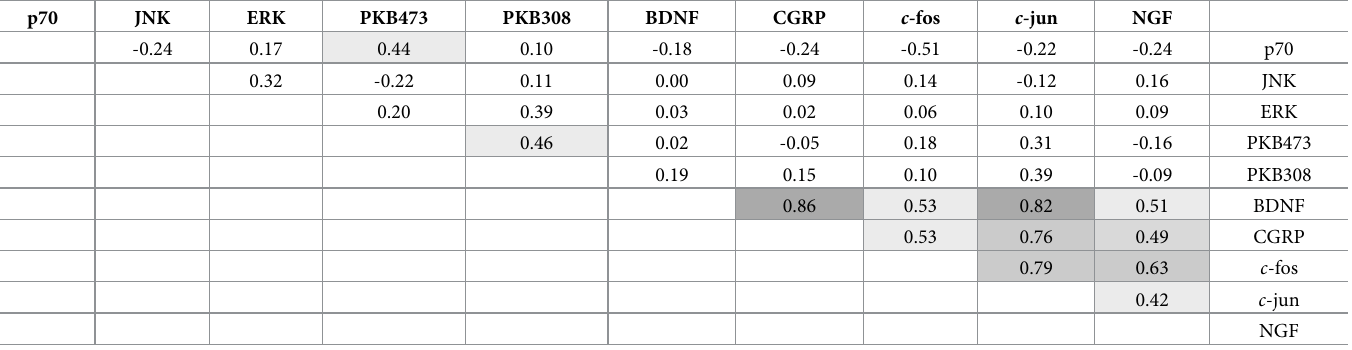
Table 2. Correlation of bone signaling activity and DRG gene expression in loaded limbs. There were mild positive correlations between PKB308 and PKB473 bone signaling. In loaded limbs, expression of genes examined was related. No correlations were found between bone signaling and DRG gene expression. Spearman rank (S R ) correlation values listed for combined loaded right and left limbs. Shading represents significant correlations, darker indicating stronger correlation